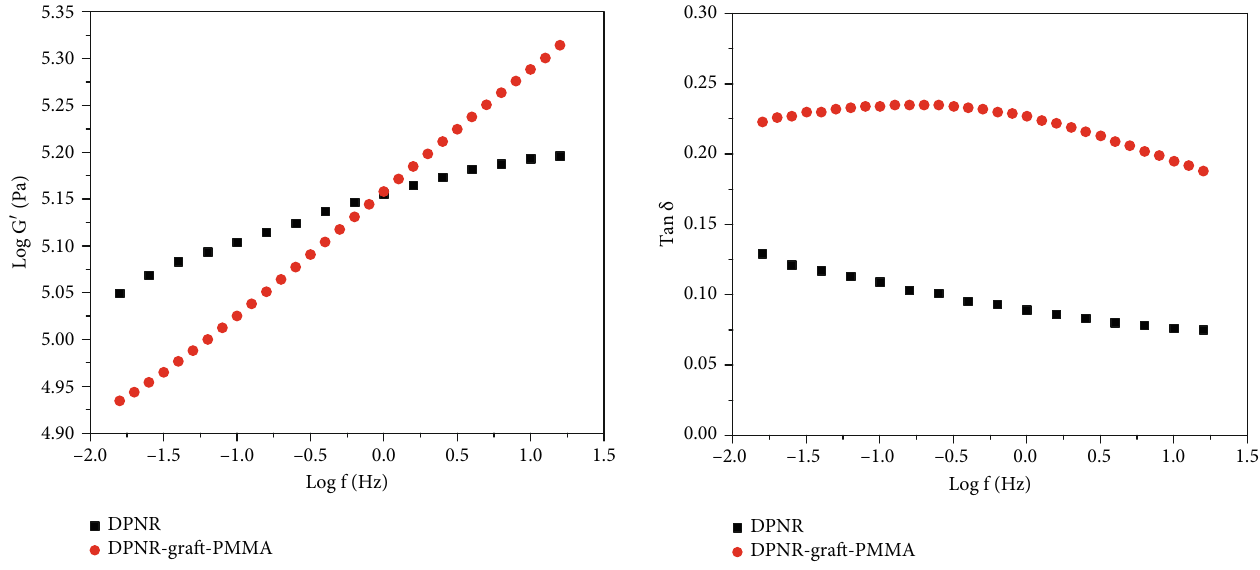
Figure 8: Storage modulus (G ′ ) in the plateau region vs frequency at 298 K for DPNR and DPNR-graft-PMMA 15wt.%.